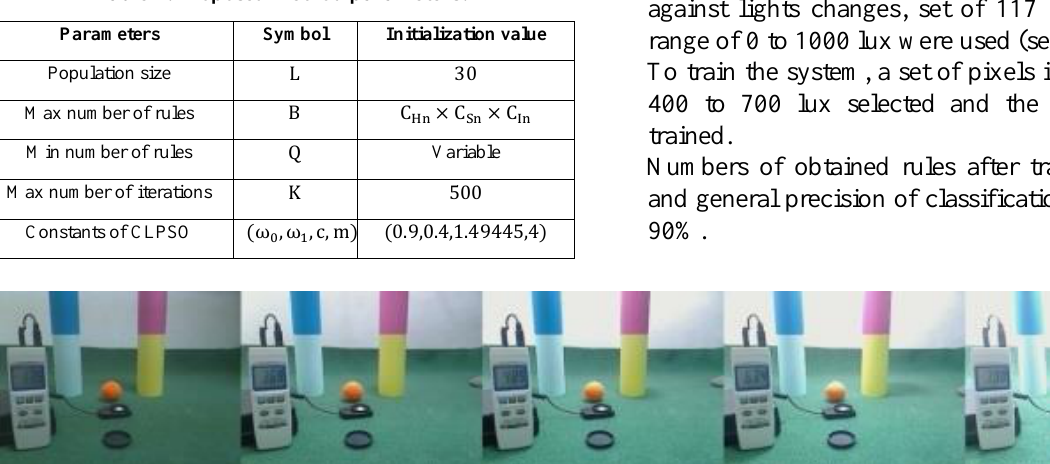
Table 1. Proposed method parameters.